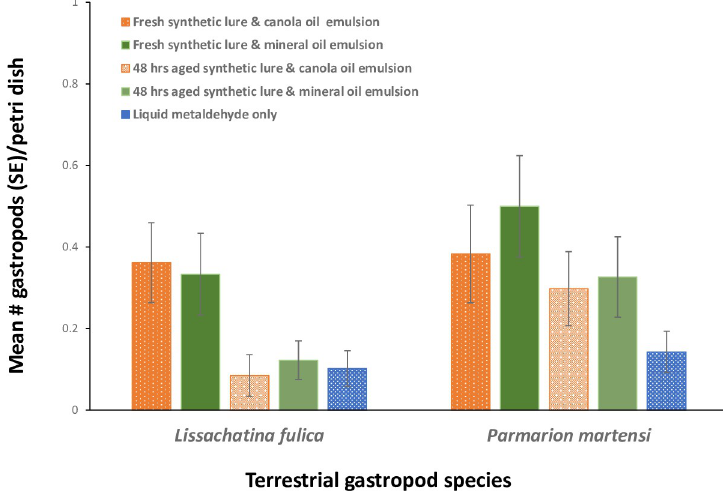
Fig 4. The mean number of giant African snails ( Lissachatina fulica ) and semi-slugs ( Parmarion martensi ) found in or near (15 cm) Petri dishes baited with wicks saturated with fresh or 48 h aged synthetic papaya odor lure (0.2%) combined with either mineral or canola oil and fresh liquid metaldehyde emulsion or liquid metaldehyde alone. Bars represent one standard error of the mean. Emulsions were 1:1:0.2 water/oil/ Tween 1 80.